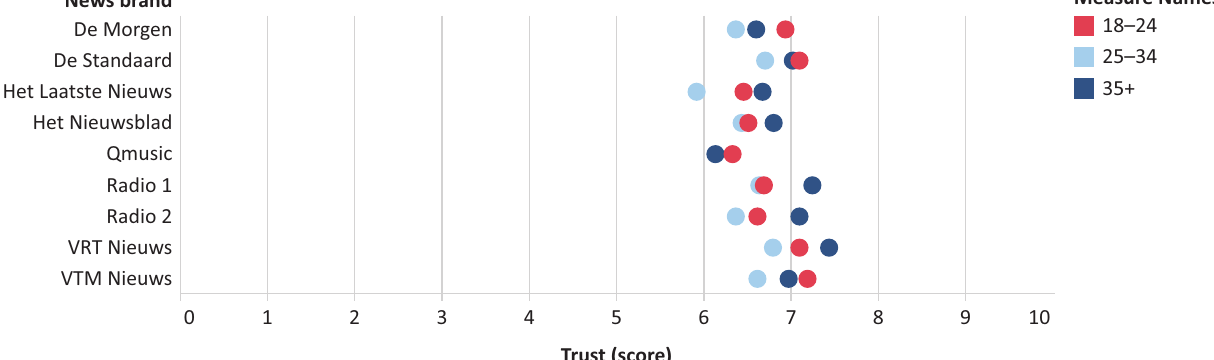
Figure 1. Trust in news brands by age. Notes: The question was ‘How trustworthy would you say news from the following brands is? Please use the scale below, where 0 is “not at all trustworthy” and 10 is “completely trustworthy.”’ See Table 1 in Supplementary File Annex 2 for exact numbers and statistical significance tests.